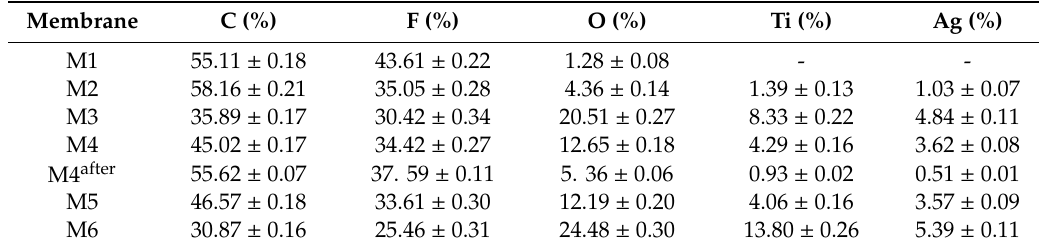
Table 4. Chemical compositions of the modified membranes. (The standard deviation (S.D.) was obtained from 1 sample of each